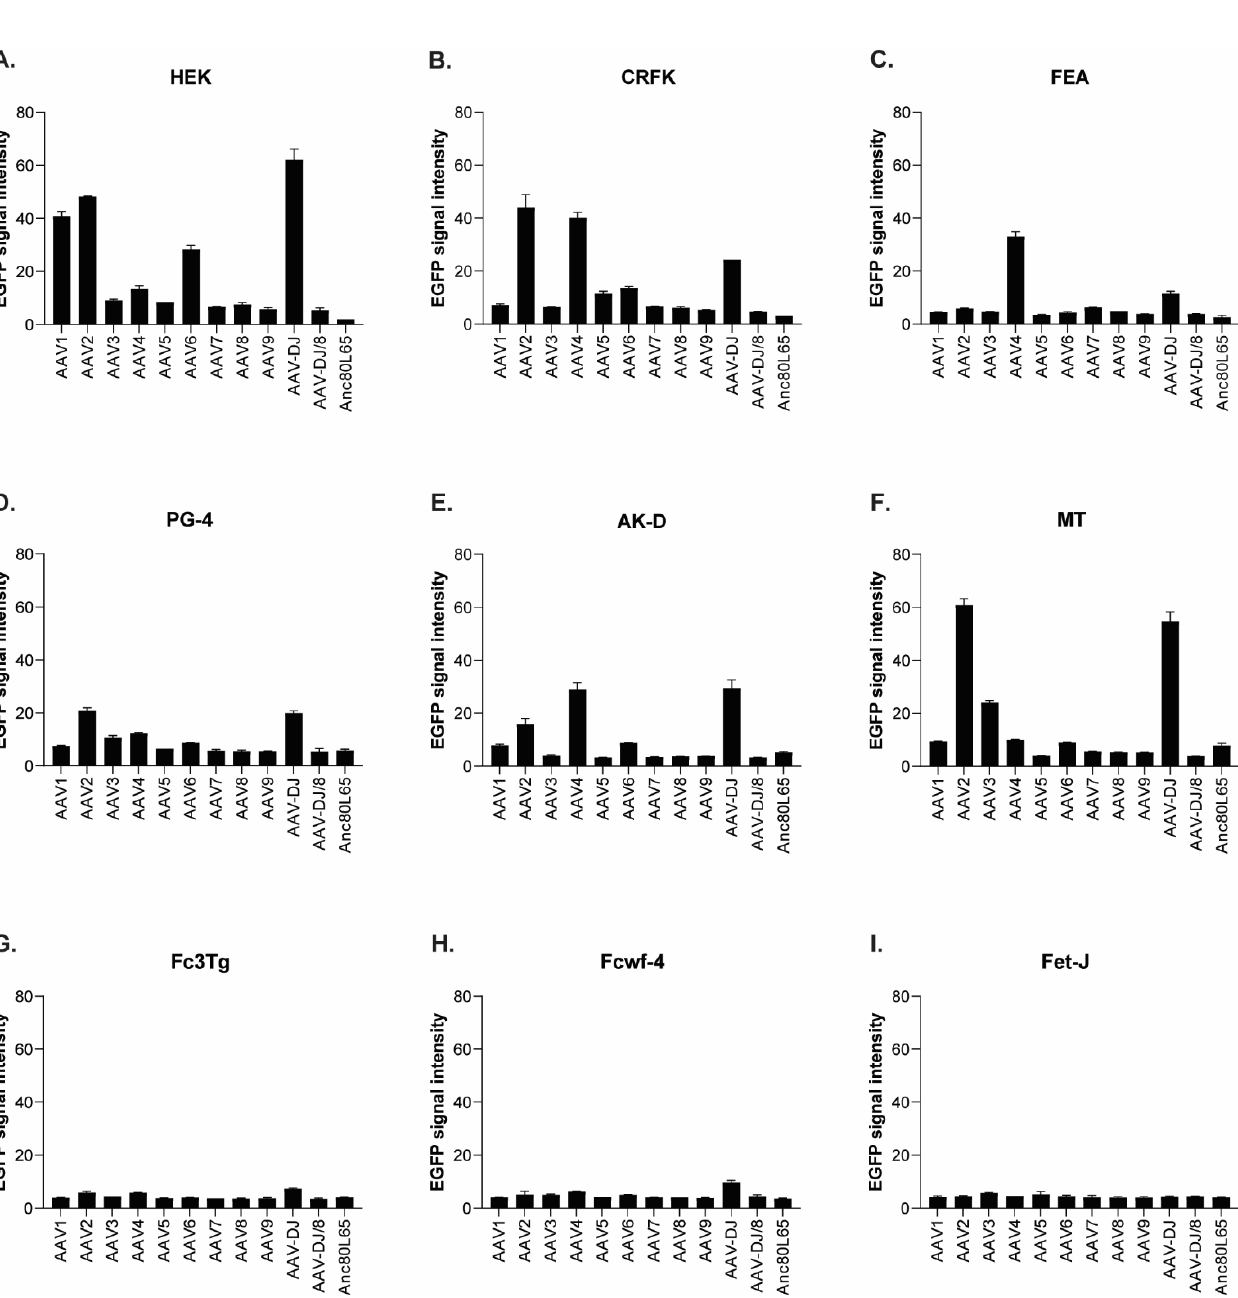
Figure 4. Quantification of the mean fluorescence signal intensity of cells infected with 12 AAV serotypes. ( A ) HEK (MOI of 10,000), ( B ) CRFK (MOI of 10,000), ( C ) FEA (MOI of 10,000), ( D ) PG-4 (MOI of 100,000), ( E ) AK-D (MOI of 100,000), ( F ) MT (MOI of 50,000), ( G ) Fc3Tg (MOI of 50,000), ( H ) Fcwf-4 (MOI of 10,000), and ( I ) Fet-J (MOI of 100,000) cells infected in duplicates ( N = 2), with 12 AAV serotypes, all EGFP tagged. Mean signal intensity is shown for the highest MOI applied in the respective cell line, ranging from 10,000 to 100,000 on day 3. The signal strength ranges between 0 (black) and 255 (white).